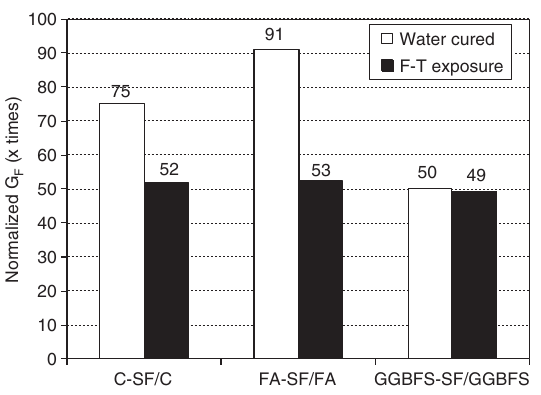
Figure 10 Normalized fracture energy of fiber-reinforced SCRM compared to the plain matrices without